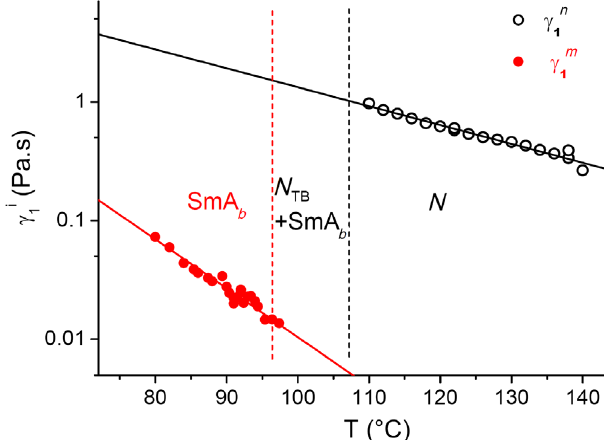
FIG. 13. Rotational viscosities of the BP12 mixture for reor- ientation of n in the N phase (open black symbols) and m in the Sm A phase (full red symbols). The solid straight lines show b exponential decay fits of the viscosities (Arrhenius-law